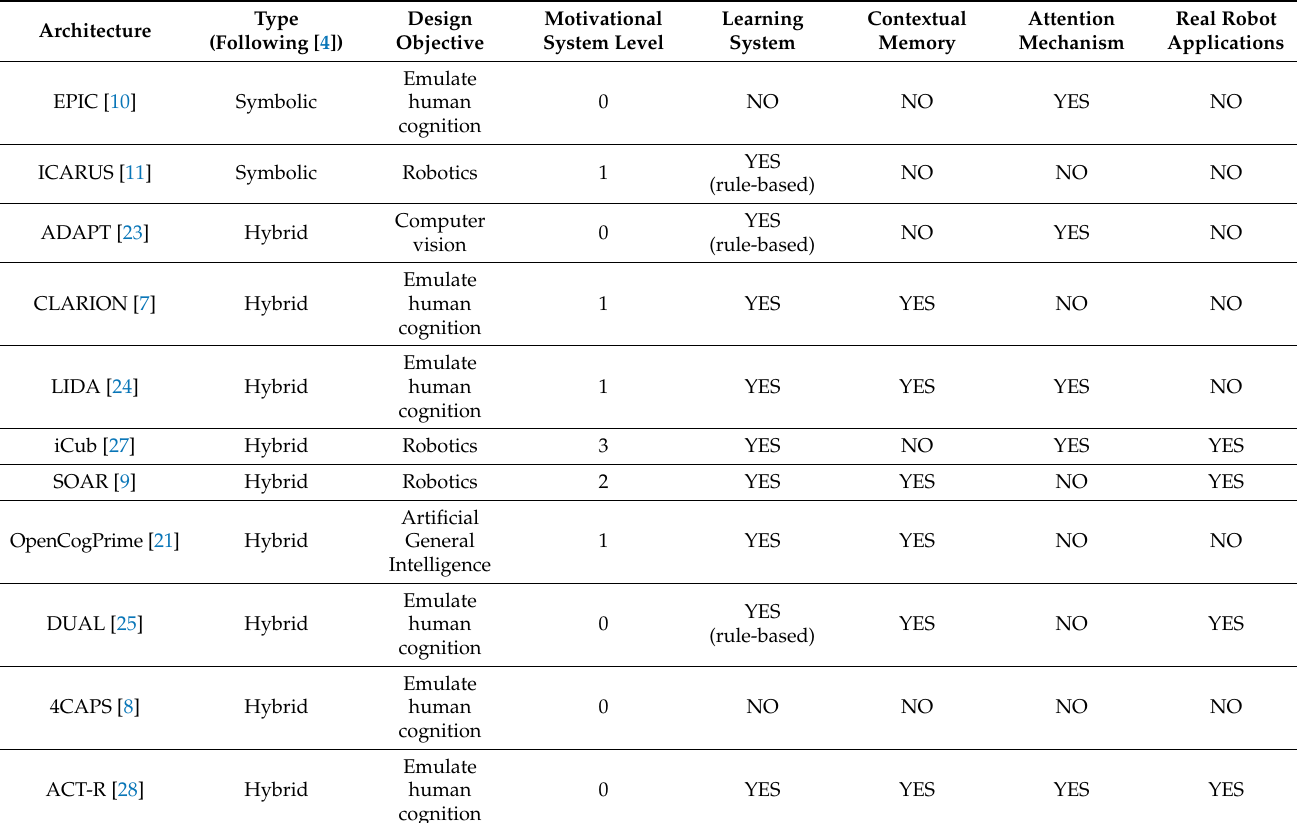
Table 1. Features of the cognitive architectures under